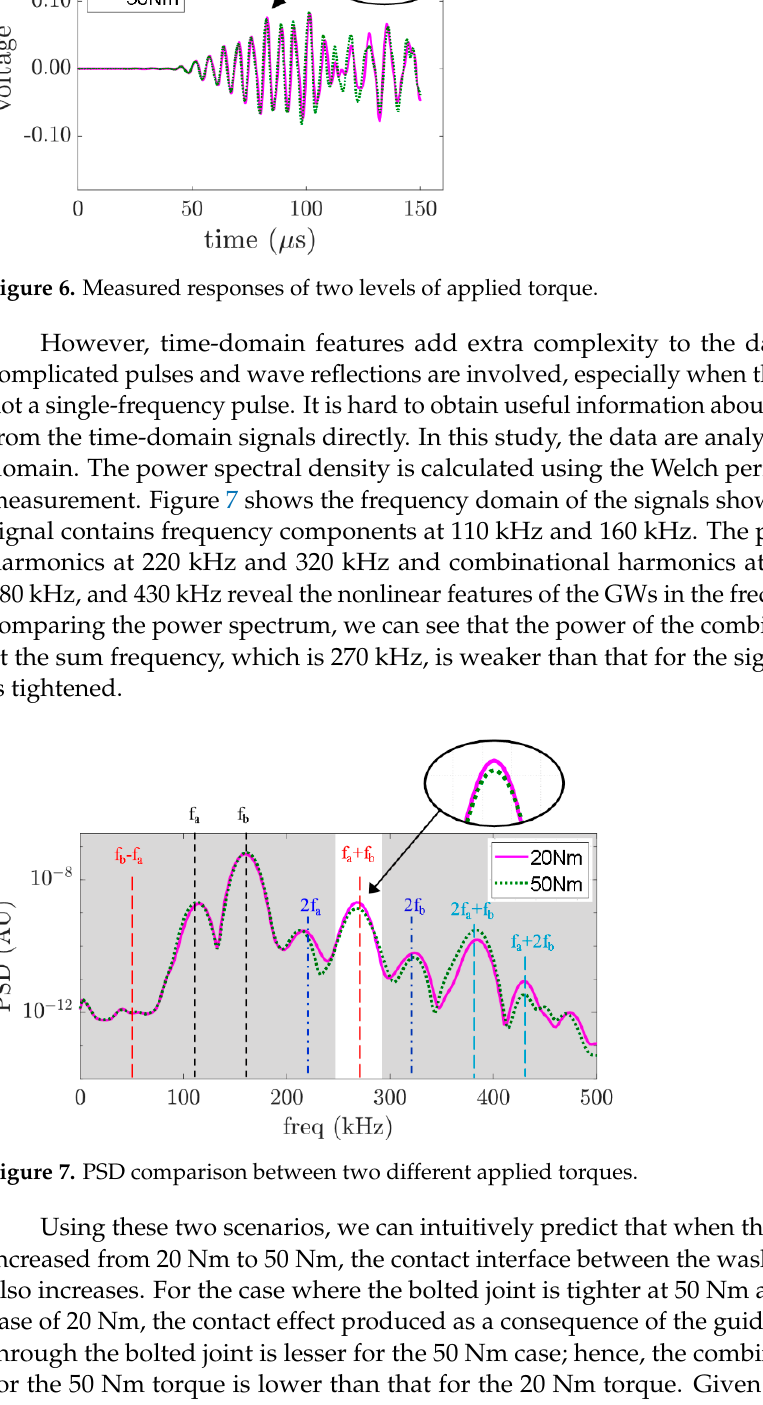
Figure 8. PSD comparison between four different levels of applied torque at the sum frequency component. To further demonstrate the proposed mixed-frequency technique in monitoring bolted joints, the relationship between the applied torque and the areas of power spectral density in the region of the combinational harmonic at the sum frequency within a 32 ± 4 kHz bandwidth were calculated for all five measurements. The averaged values are shown in Figure 9. A decreasing trend is notably observed. The results are consistent for all five measurements and show that the proposed approach can be used as an indicator for applied bolt torque.